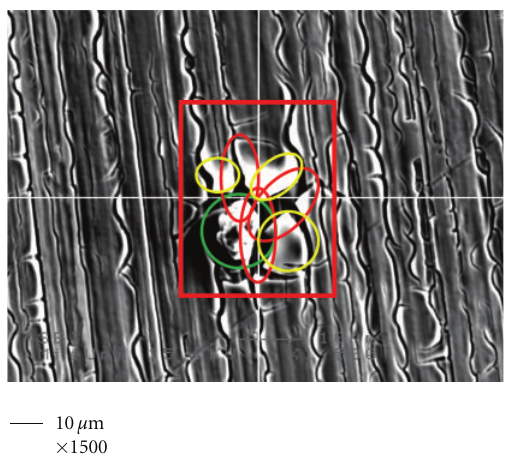
Figure 4: SEM images of Cr-doped TiO 2 film prepared under the condition of R = 1